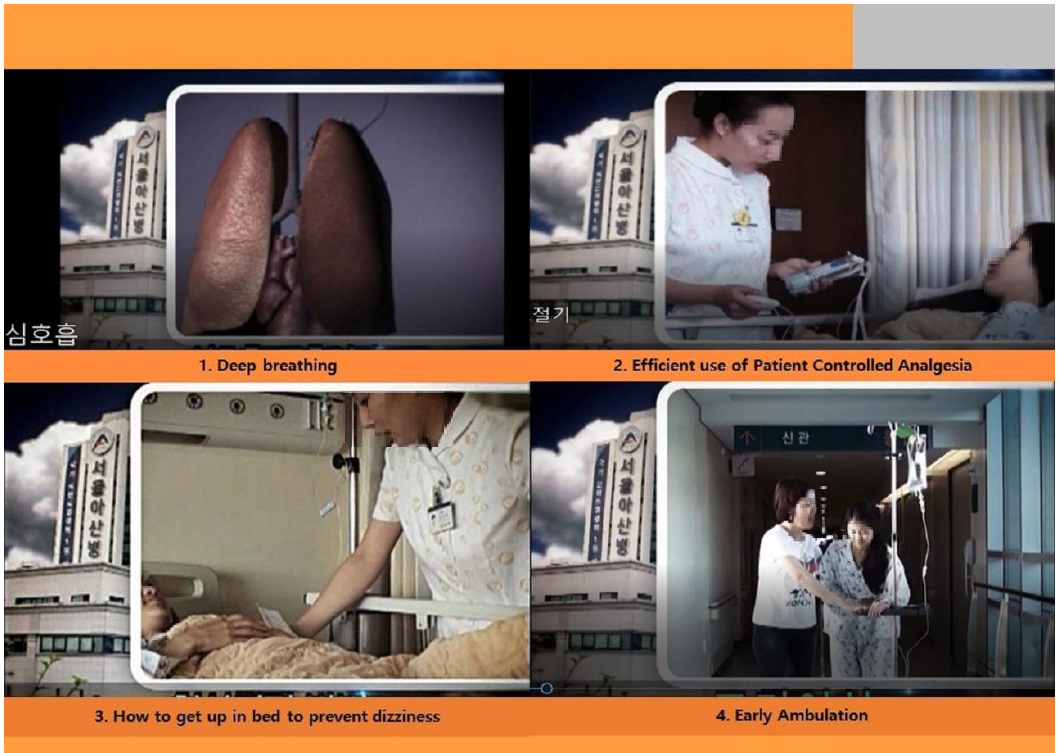
Figure 2. Anticipatory integrated education program (video screen capture). Video screen capture of footage on deep breathing, inspirometer use, intravenous patent-controlled analgesia use, the stepwise standing up method, and early ambulation. Reproduced with permission from EES, YHS, HJP, ESL.